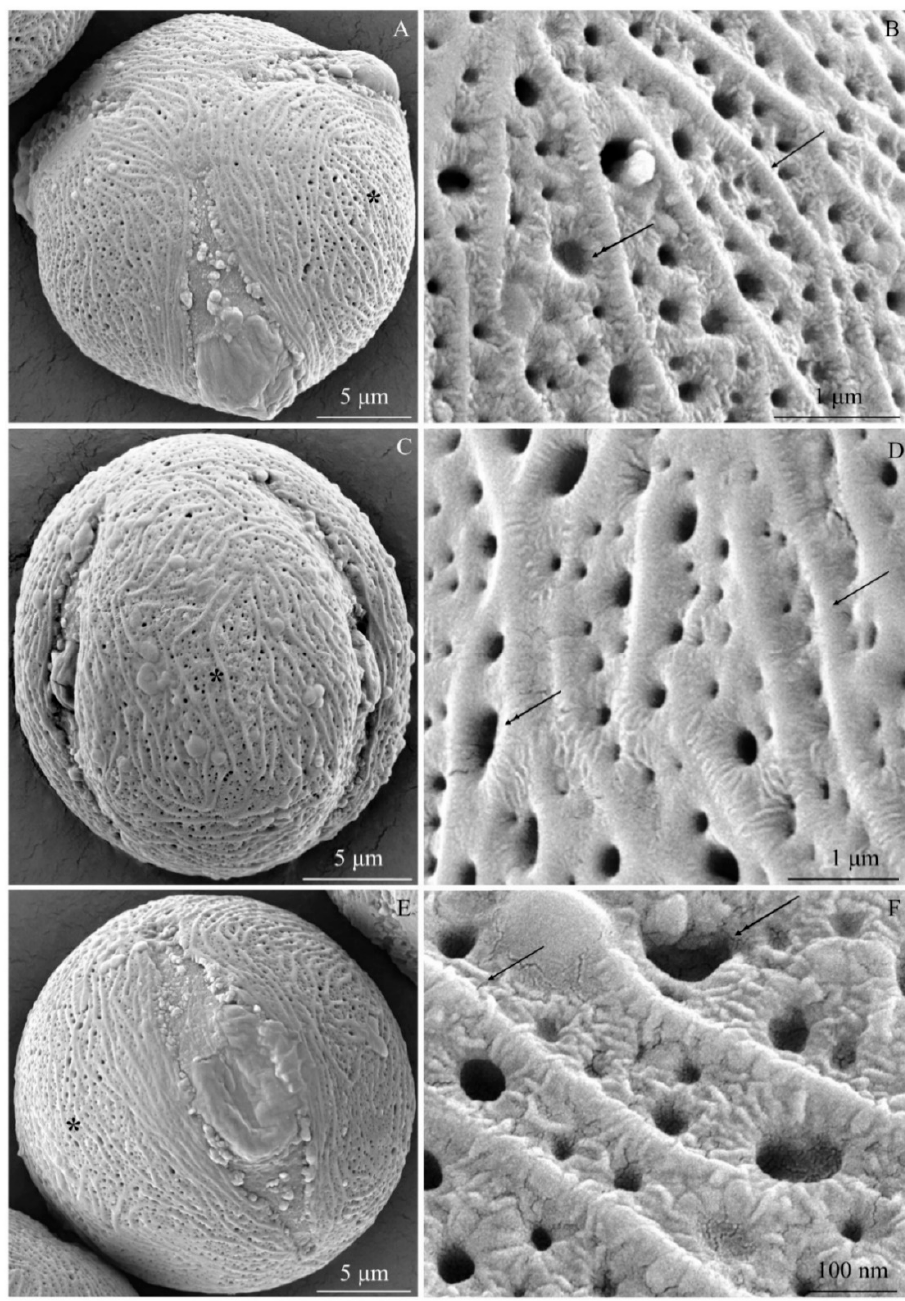
Figure 3. ( A – F ). Pollen grains ( A , C , E ) and fragments of exine surface sculpture ( B , D , E ) in Rubus idaeus ‘Radziejowa’: ( A , B )—polar view, ( A ) muri arranged in parallel along the colpus, with an arcuate bend in the middle part between colpi, sometimes branched near the apocolpium, ( B ) distinctly visible muri (arrow), di ff erent width of colpi and diameter of perforations (double-headed arrow), visible striation arranged radially at perforations and perpendicular to muri; ( C , D )—equatorial view, ( C ) muri running towards the polar axis with varied arrangement: parallel, arcuate, and overlapping, ( D )—perforations with di ff erent diameters (double-headed arrow), visible radial exine striation around perforations with di ff erent heights of protuberances and arranged perpendicular to muri (arrow); ( E )—colpus reaching the poles with a visible porus, exine with numerous perforations; ( F )—several rows of perforations (double-headed arrow) in the colpus, visible delicate striation around the perforation and on the surface of muri (arrow). ( A – F ) - SEM.